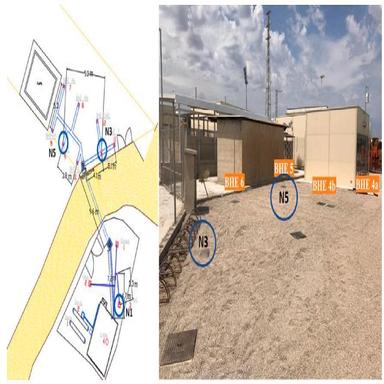
Section of the borehole with (a) 140 mm diameter (b) 126 mm diameter.